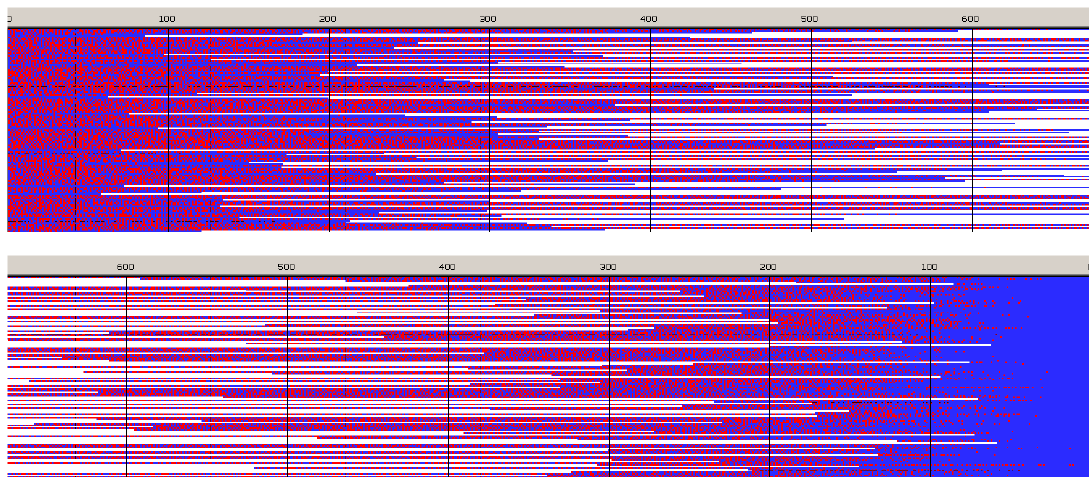
Figure 7. Sample of simulated chains in copolymerization initiated with S - Ini (mixture of Lac * and Tmc * unimers). Reactivity ratios z LL = 37.6, k ex / k TT = 8.1. Other conditions as in Figure 6. Conversion 95%, DP n = 506.4, Ð = 1.40, average number of homoblocks in a chain equal to 292.